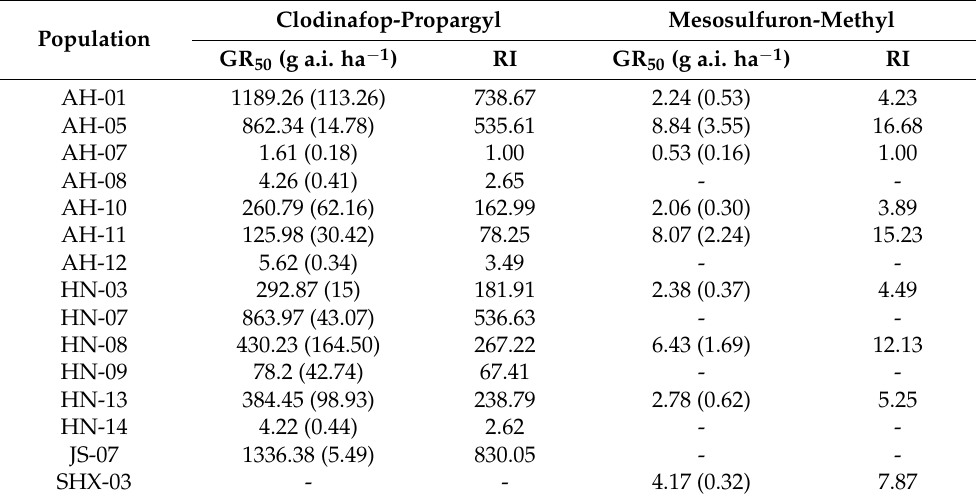
Table 5. The GR 50 values a and RIs b to clodinafop-propargyl and mesosulfuron-methyl in different resistant populations of L. multiflorum